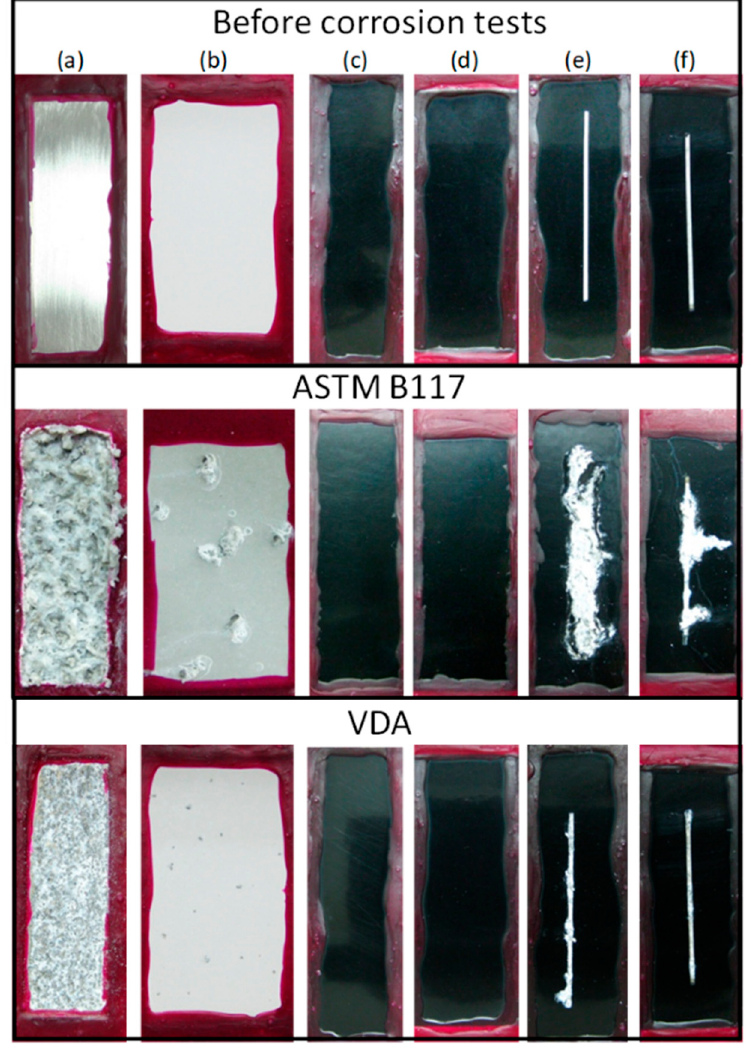
Figure 21. The surface appearance of AZ31 specimens before and after accelerated corrosion tests: ( a ) untreated, ( b ) PEO, ( c ) Ti/Zr + polymer, ( d ) PEO + polymer, ( e ) scribed Ti/Zr + polymer and ( f ) scribed PEO + polymer [63]. Reprinted from [63] with permission from Elsevier.